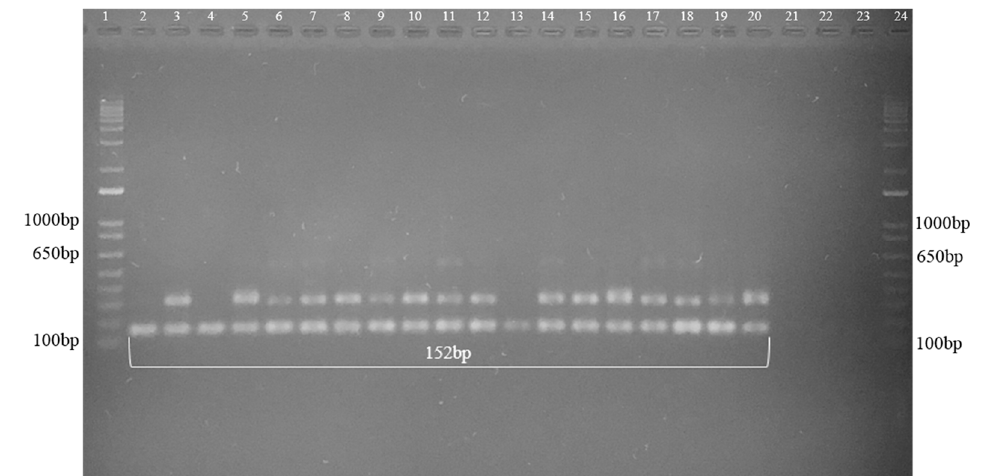
Figure 1. Representative nested-PCR agarose gel of the DNA extracted from soil samples, demon- strating 16 amplified fragments with the amplification of 152 bp fragments. 1 and 24 = Molecular Weight (1 kb Plus–Invitrogen), 2 to 10 = samples from Seropédica, and 11 to 19 = samples from Nova Iguaçu, 20 = Positive control S. brasiliensis (IPEC 16490) and 21, 22 and 23 = Negative control.